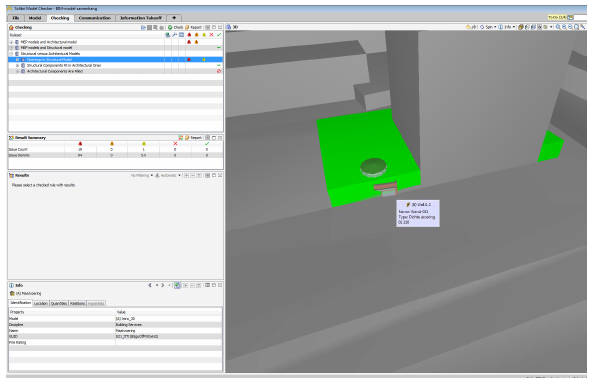
Figure 7. Model checking in IFC on spatial